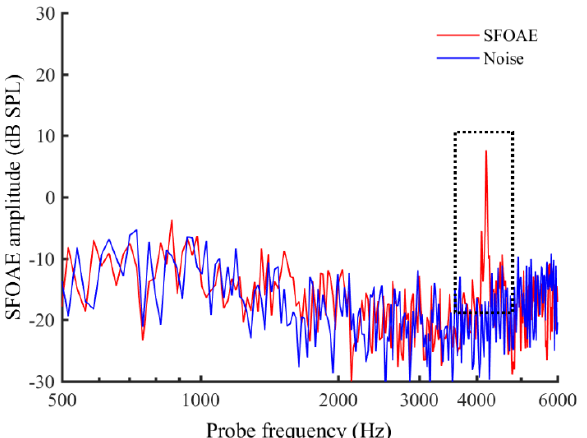
Figure 1. An example of the presence of stimulus frequency otoacoustic emission (SFOAE). Probe level was 50 dB sound pressure levels (SPL), and the center frequency (CF) is 4 kHz. Red line indicates SFOAE and blue line indicates the background noise. The presence of SFOAE is represented in the black dashed box.